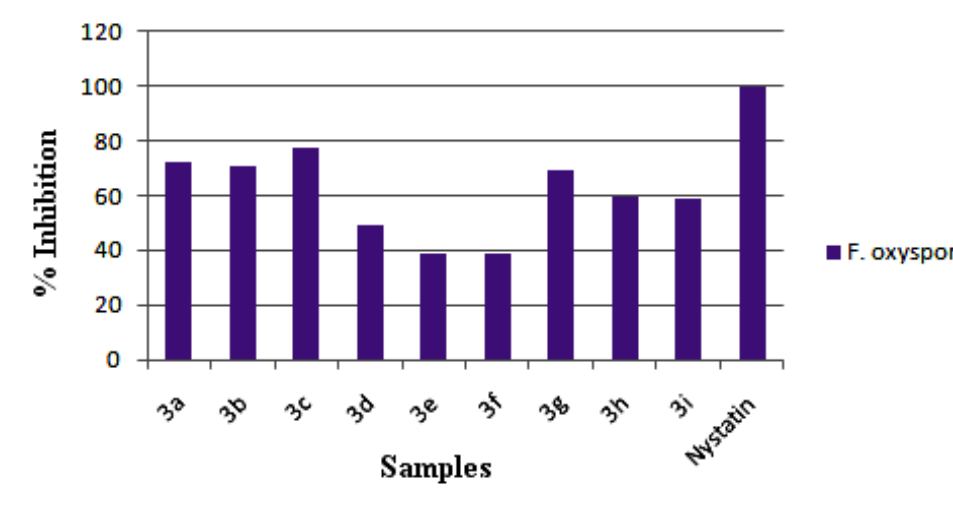
Figure 13. In vitro antifungal activity of 3 ( a–i